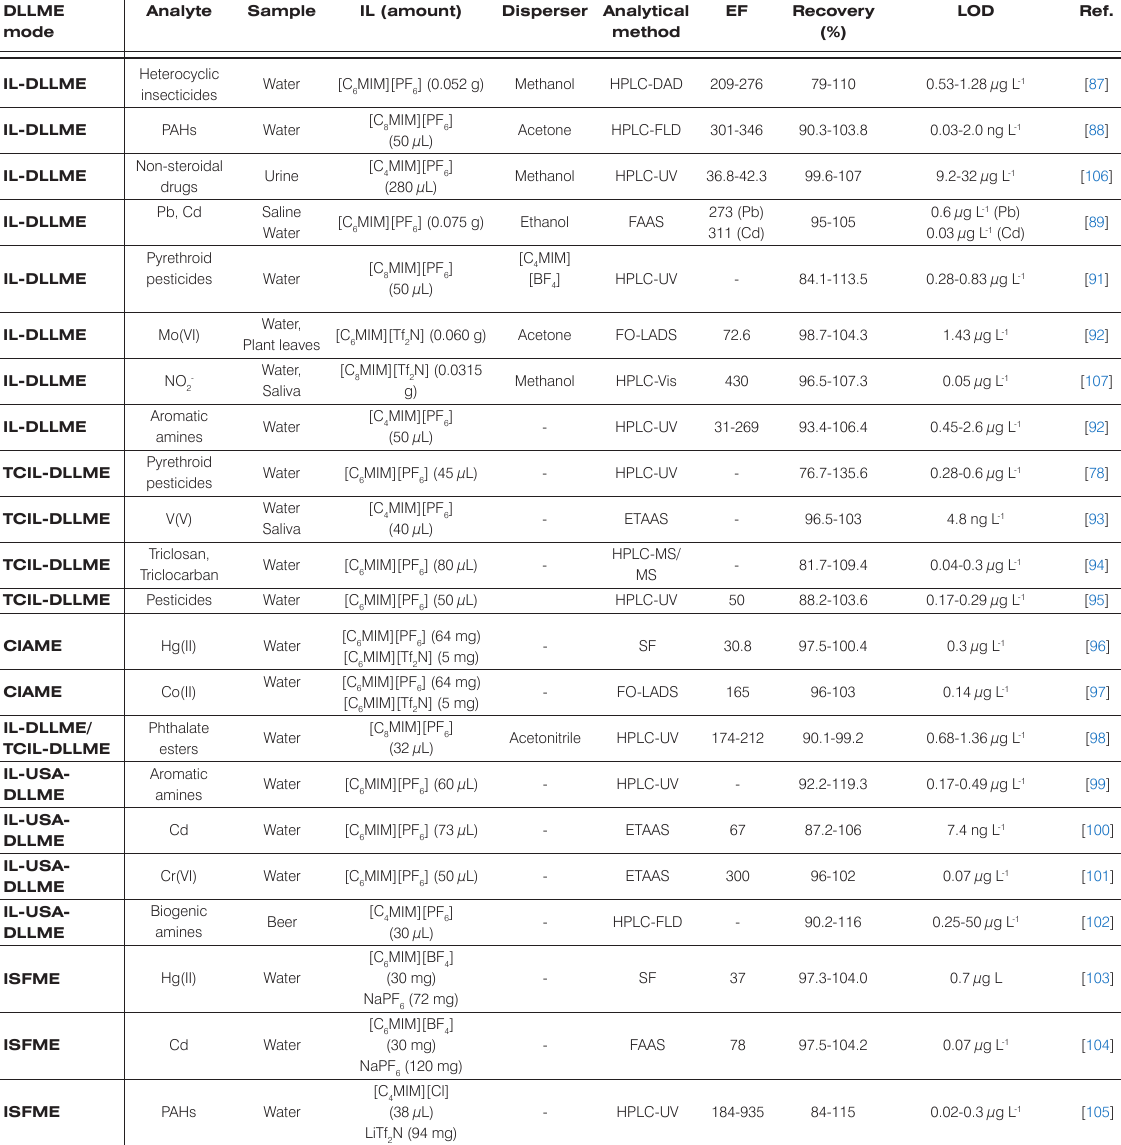
Table 4. Representative examples on the use of ILs in